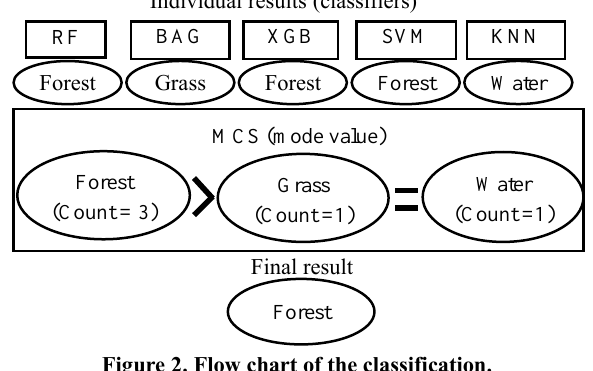
Figure 2. Flow chart of the classification.